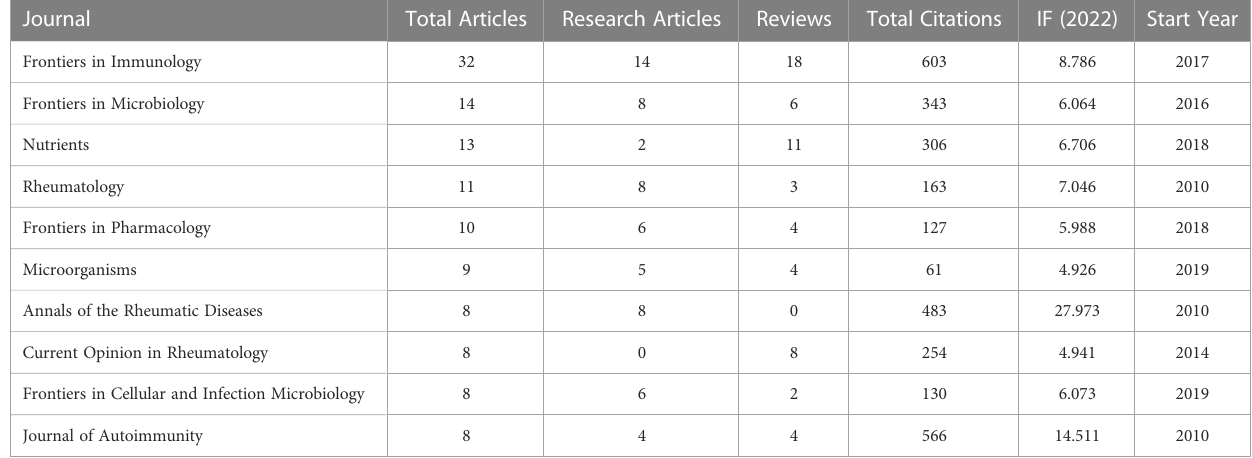
TABLE 3 The top 10 journals with the most